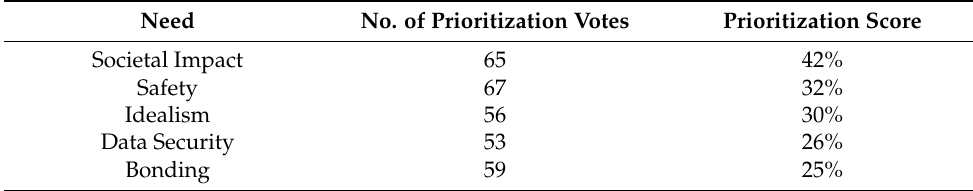
Table 6. Prioritization Results for the Target Group “Adulthood”.